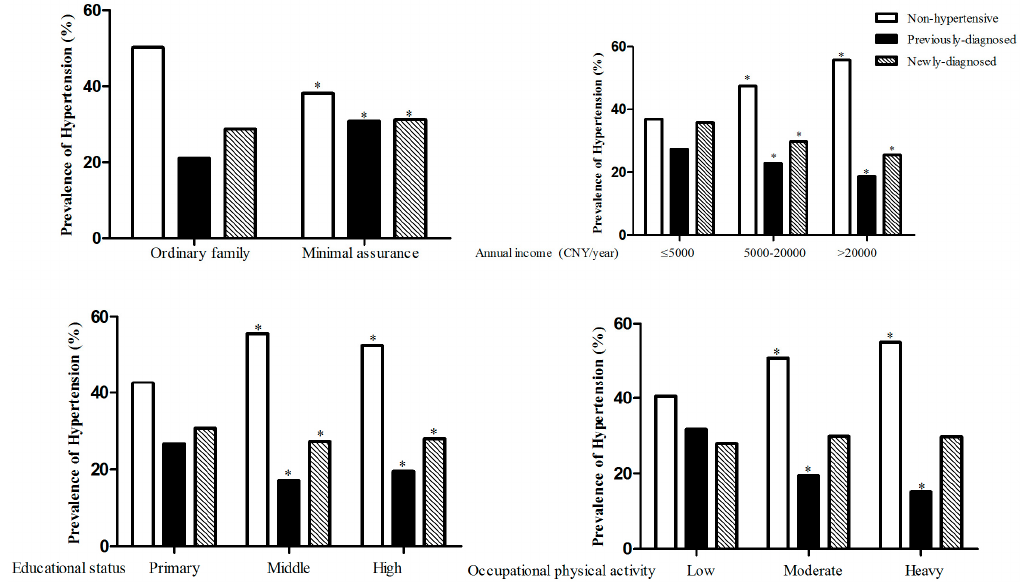
Figure 1. Prevalence of hypertension according to minimal assurance and socioeconomic status. * p < 0.05.